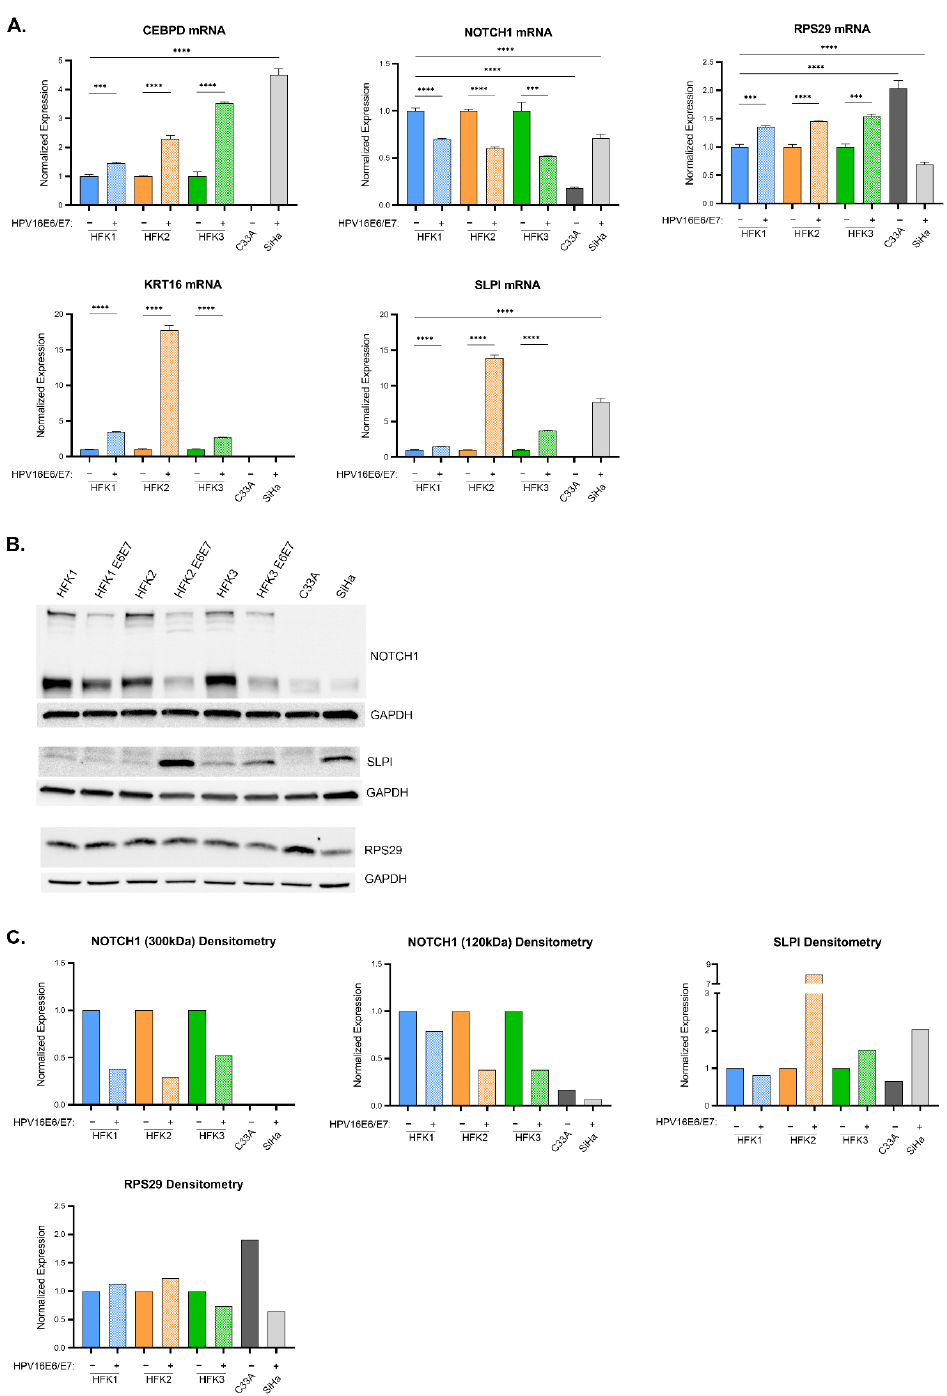
Figure 5. Expression of LASSO-identified genes in in vitro models of cervical disease. ( A ) CEBPD, KRT16, NOTCH1, SLPI, and RPS29 transcript levels (determined by qPCR) in HFK1-3 with and without HPV 16E6E7, as well as cancer cells C33A and SiHa. Samples are normalized to a housekeeping gene (36B4 or GAPDH) and for HFKs to their respective parent and cancer cells to HFK1. Error bars represent standard deviation for technical replicates ( n = 3 for HFKs; n = 9 for cancer cells). Asterisks denote significant differences between HFK cells with and without HPV 16E6E7, and between either cancer cell or HFK1 as determined by Student t -Test. p value: *** = 0.0002; **** ≤ 0.0001. ( B ) Representative immunoblots of NOTCH1, SLPI, and RPS29 are shown. GAPDH is included as a loading control. ( C ) Densitometry of shown immunoblots (NOTCH1, SLPI, and RPS29). Samples normalized to GAPDH, and to the parent HFK for HFK1-3 and to HFK1 for the cancer cells. Two distinct bands were detected for NOTCH1 (300 kDa and 120